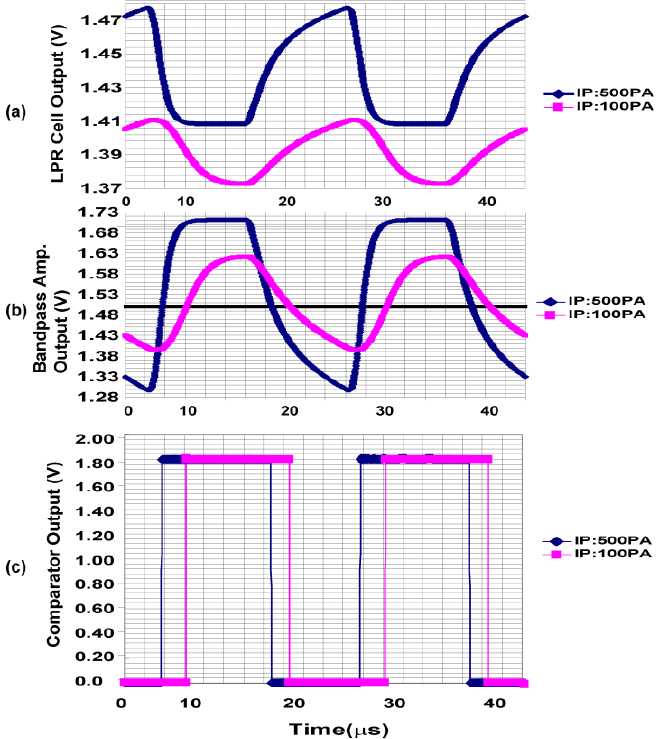
Figure 17. Simulated waveforms of the LPR cell, bandpass amplifier and comparator